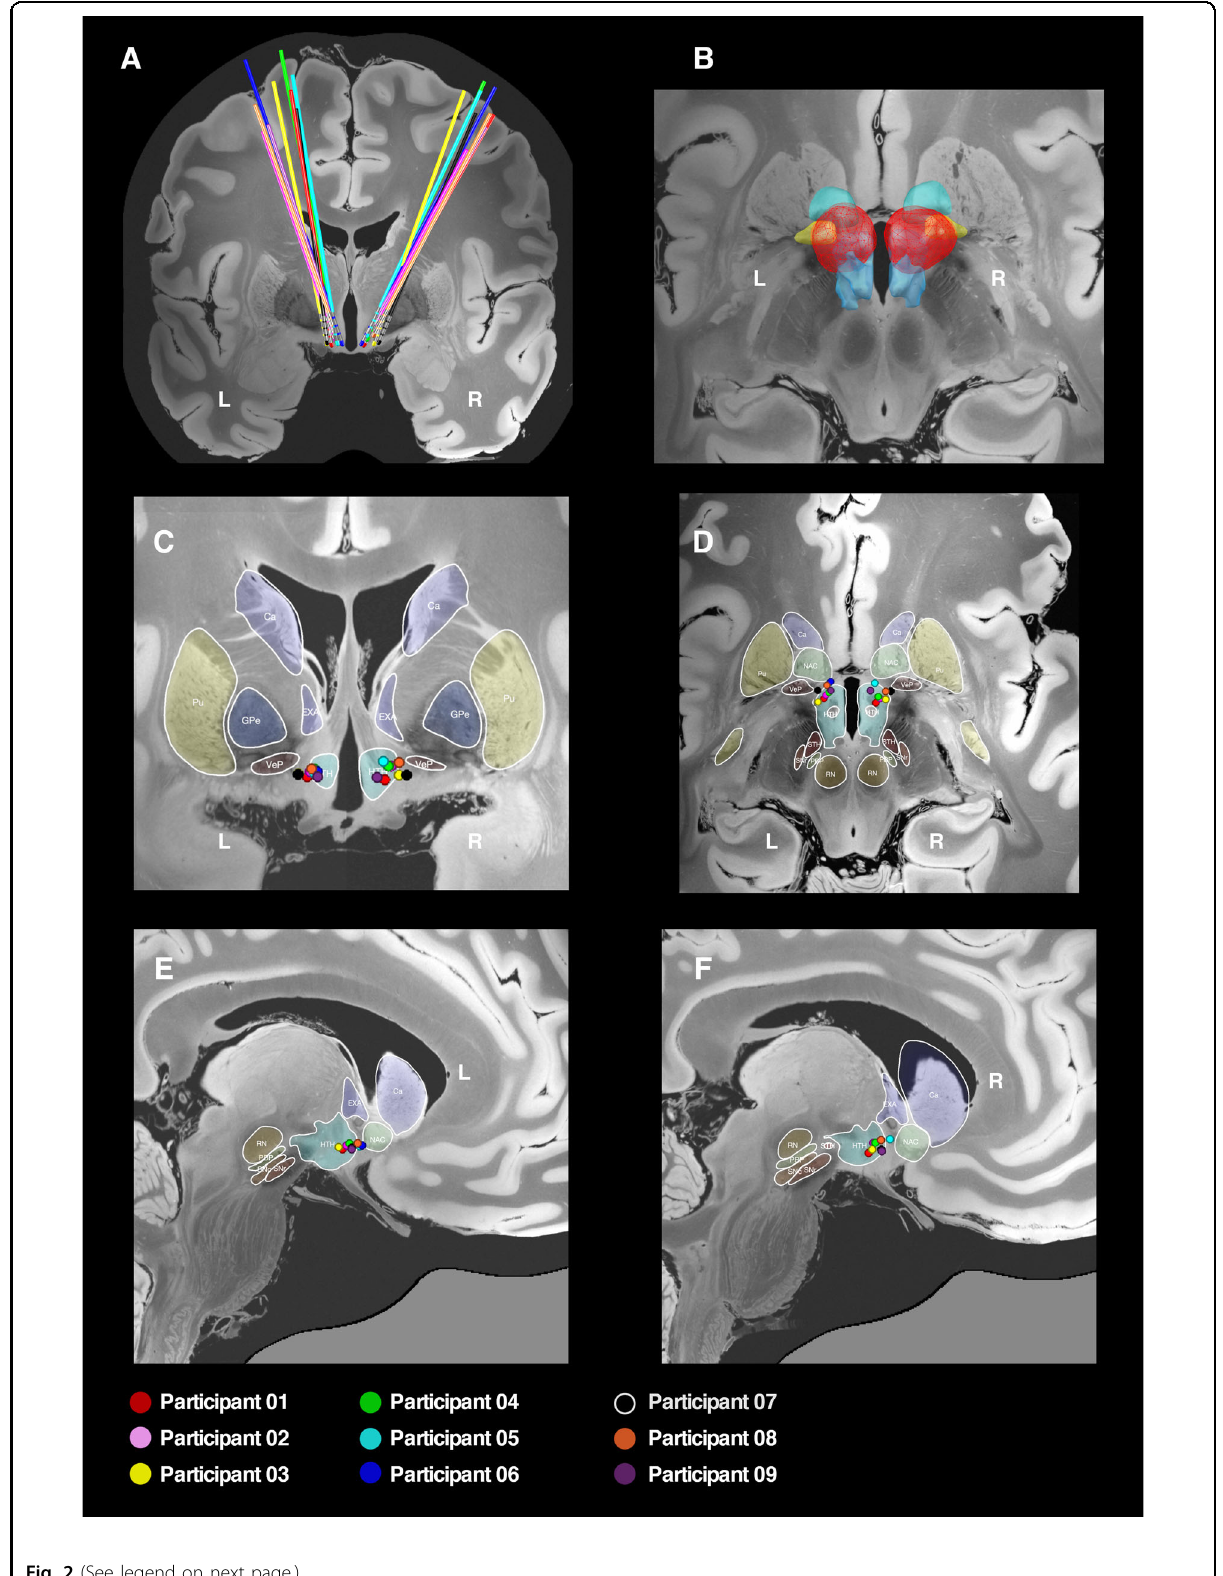
Fig. 2 (See legend on next